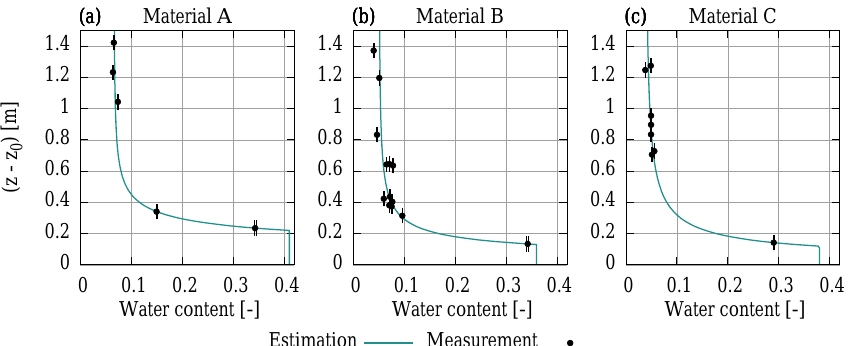
Figure A2. We use the Brooks–Corey parameterization to estimate the initial water content distribution between the TDR sensors. As- suming hydraulic equilibrium, we approximate the matric potential h m with the negative distance to the groundwater table position z 0 : h m ≈ − (z − z 0 ) . For each material, we then use the approximated matric potential at the position of the TDR sensors and the corresponding water content measurement data to fit the Brooks–Corey parameters. Each dot depicts the mean of 15 subsequent data points measured in the 4h preceding the experiment. The according standard deviations are all smaller than 0 . 002, which indicates (i) that the hydraulic system is relatively equilibrated at the beginning of the experiment and (ii) that the deviations from the estimation are statistically significant.